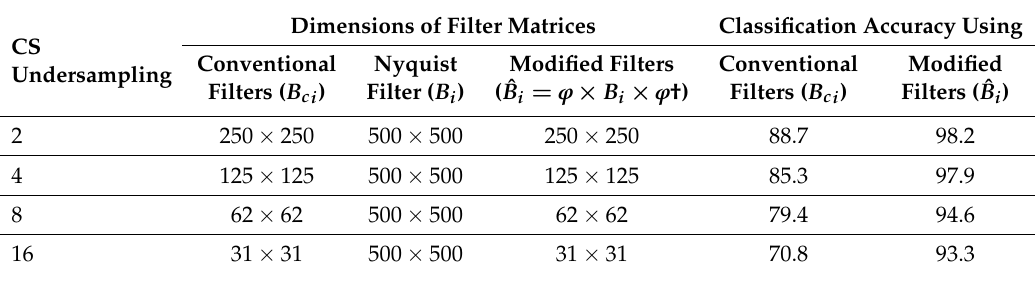
Table 2. Performance comparison of scheme using m-size conventional filters and the proposed